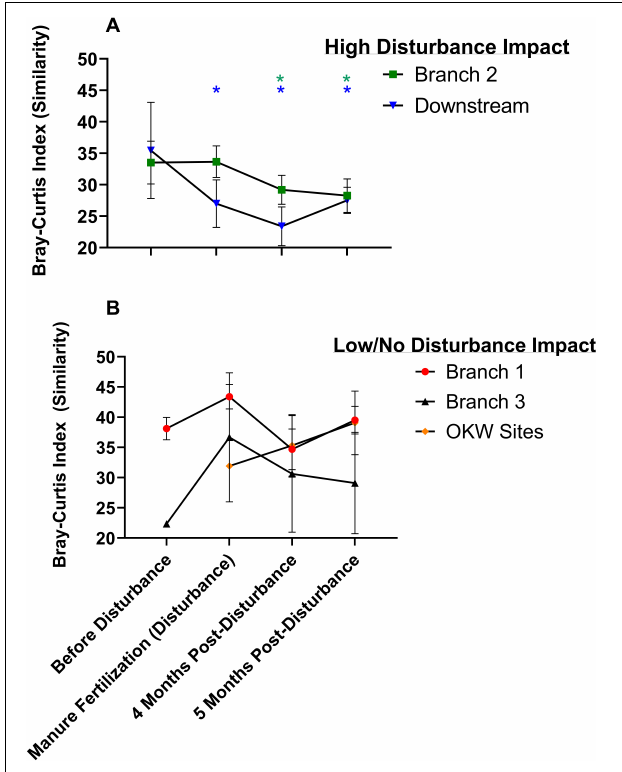
FIGURE 6 | Changes in beta-diversity based on the mean ± standard deviation of Bray-Curtis Index (similarity) in (A) river branches receiving high disturbance impact and (B) river branches receiving low or no disturbance impact. Significant decreases (PERMANOVA and post hoc tests, p < 0.05) in microbial community composition similarity within river branches between the pre-disturbance and disturbance/post-disturbance states are indicated with * in colors corresponding to the sampling branch; only high disturbance river branches were significantly less similar between the pre and post-disturbance sampling